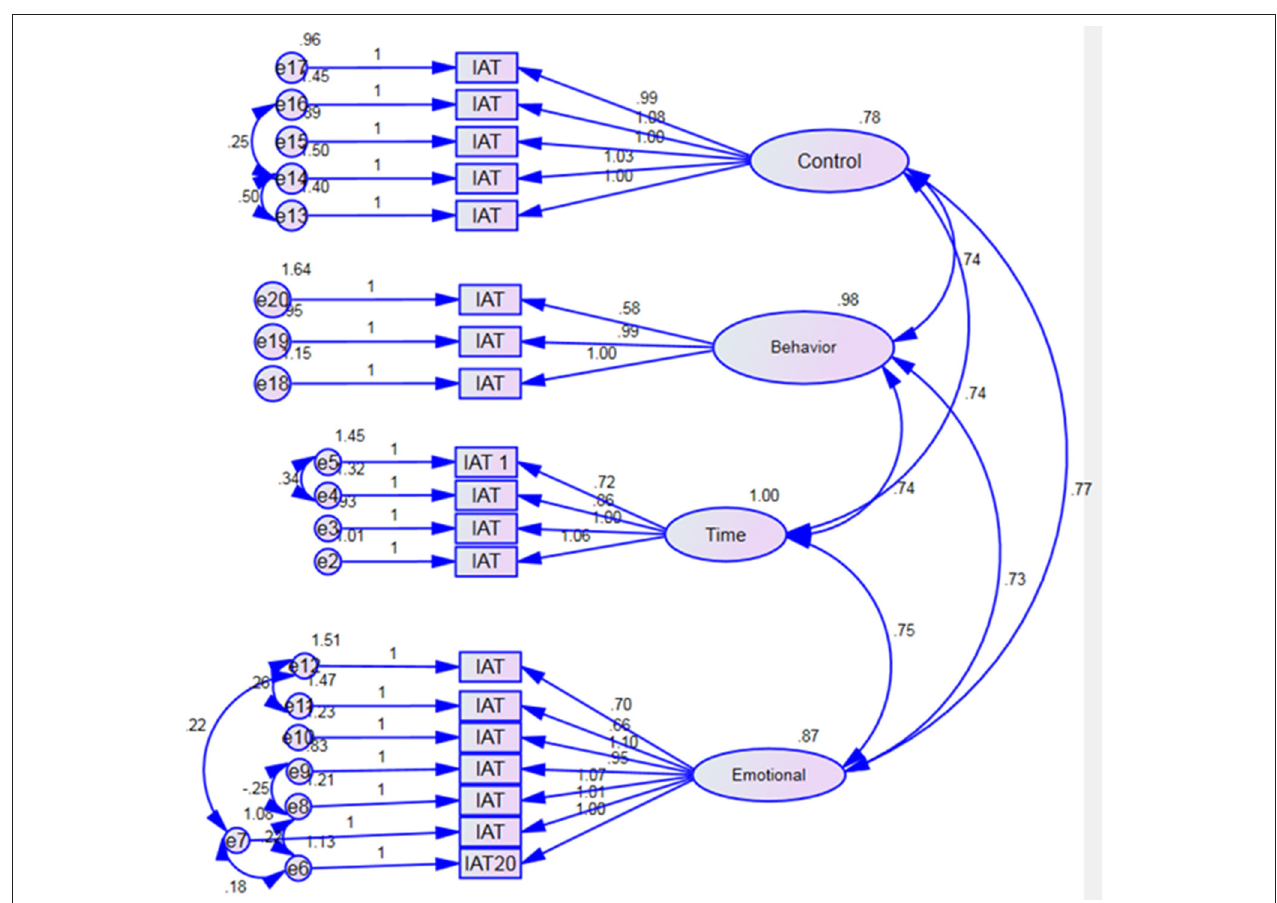
FIGURE 1 | Confirmatory factorial analyses for internet addiction test components.